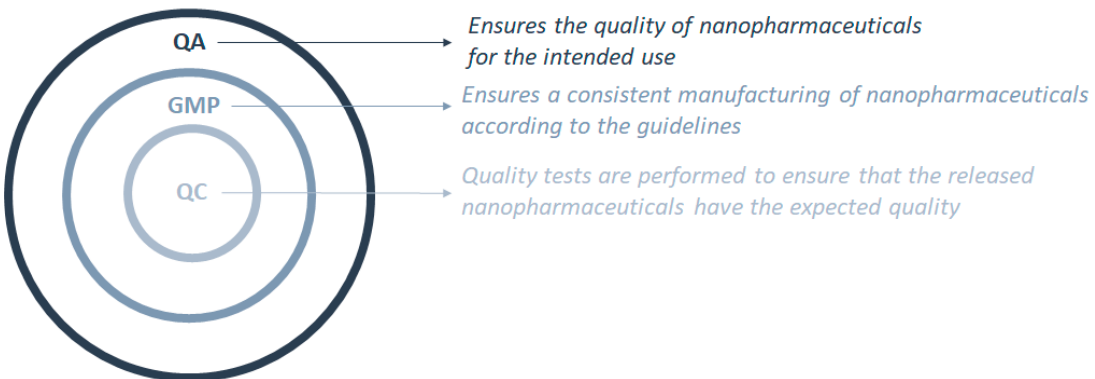
Figure 1. Interconnections between the quality control (QC) process as part of the good manufacturing practices (GMP), which are part of the quality assurance (QA) process.